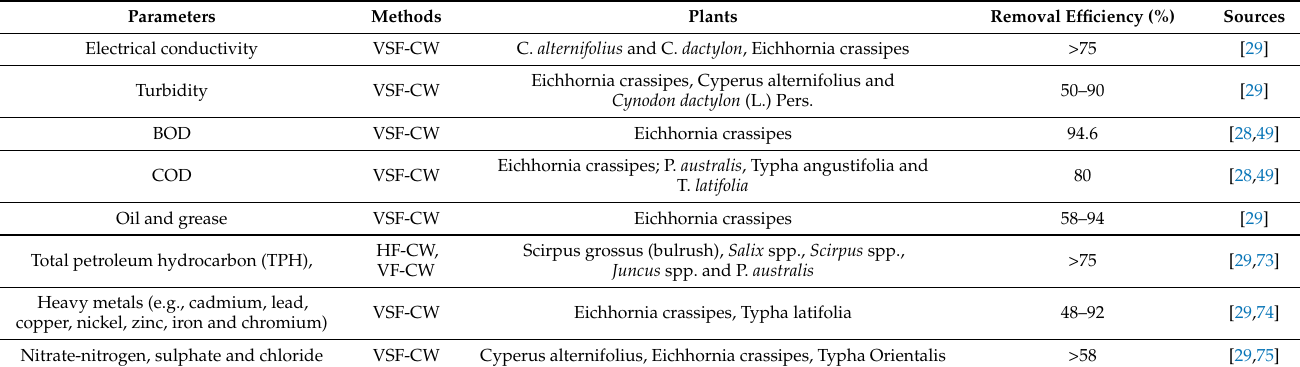
Table 3. Major contaminant removal from oil refinery wastewater in different wetland